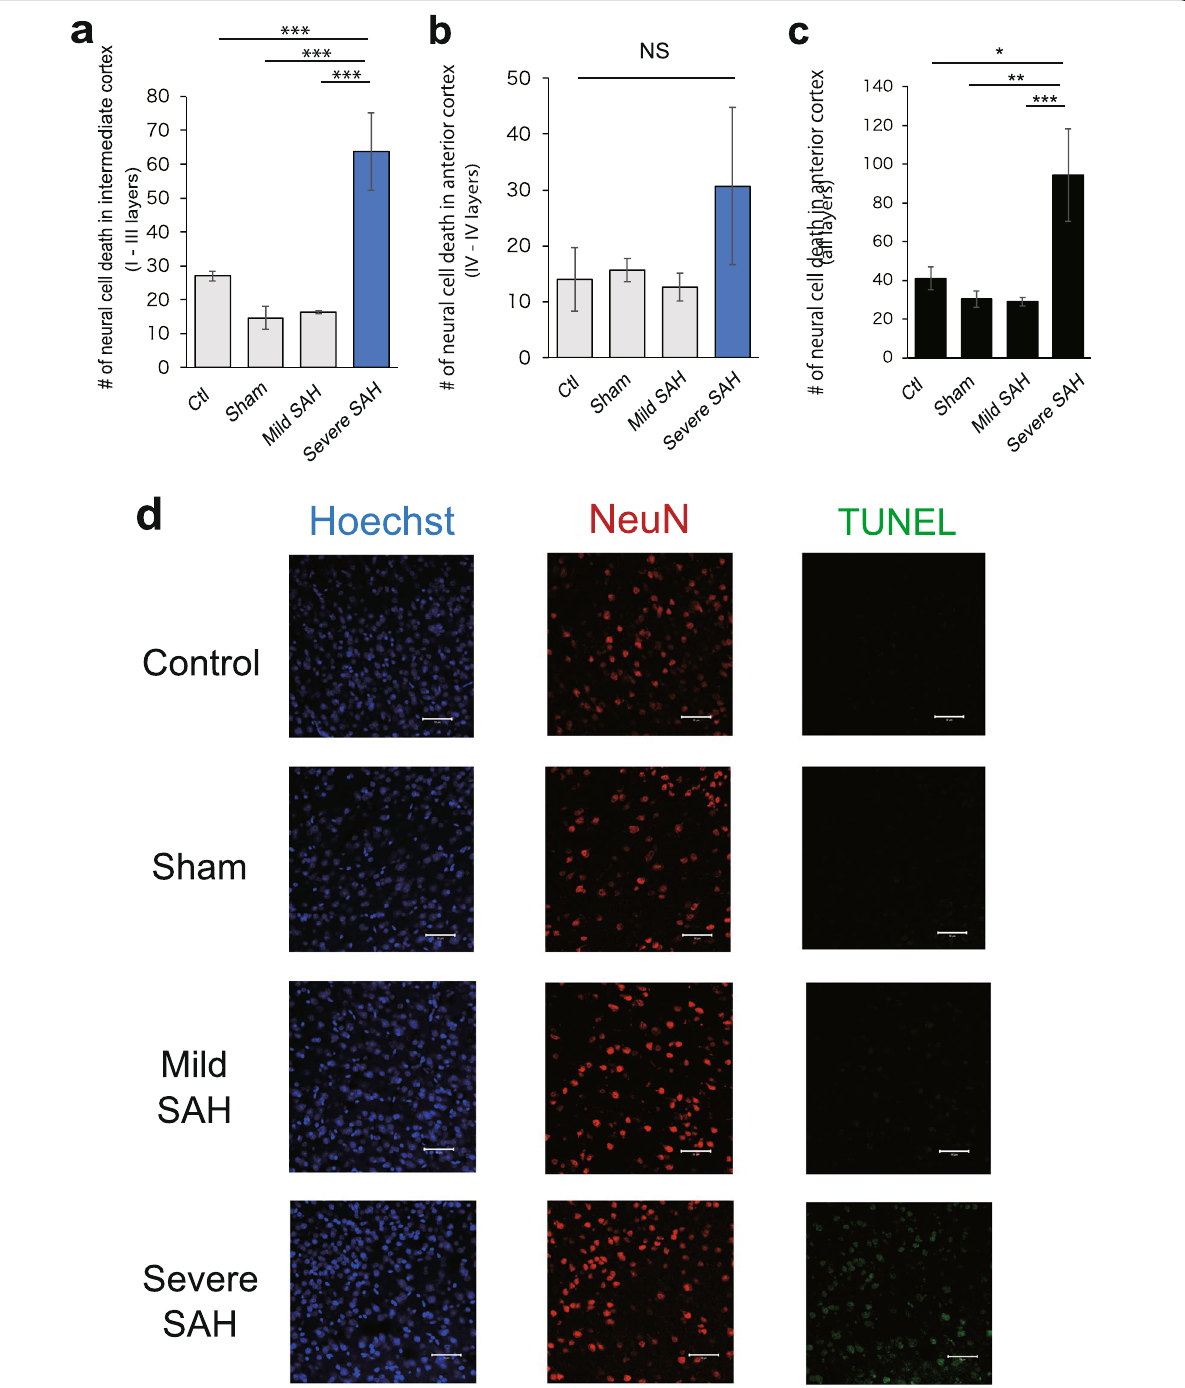
Fig. 9 Neural cell death in the intermediate cerebral cortex (1.0 mm posterior to bregma). a Quantification of the number of dead neural cells in layers I to III of the intermediate region of the cerebrum ( n 3). b Quantification of the number of dead neural cells in layers IV to VI of the = intermediate region of the cerebrum ( n 3, each group). c Quantification of the number of dead neural cells in all layers of the intermediate region = of the cerebrum ( n 4, each group). d Representative confocal images of TUNEL (green) and NeuN (red) in the intermediate cortex. Nuclei were = counterstained with Hoechst (blue). Scale bar, 50 μm. Statistical analyses were performed with one-way ANOVA and Tukey–Kramer post hoc tests. The values in the bar graphs represent the mean SD. * p < 0.05. ** p < 0.01, *** p < 0.001. NS: not ±